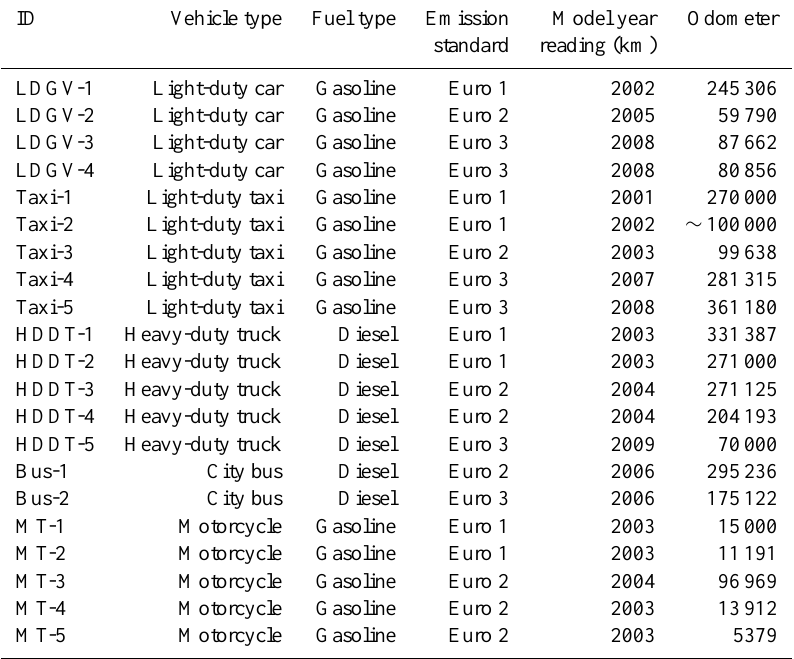
Table 2. Test vehicle specifications.